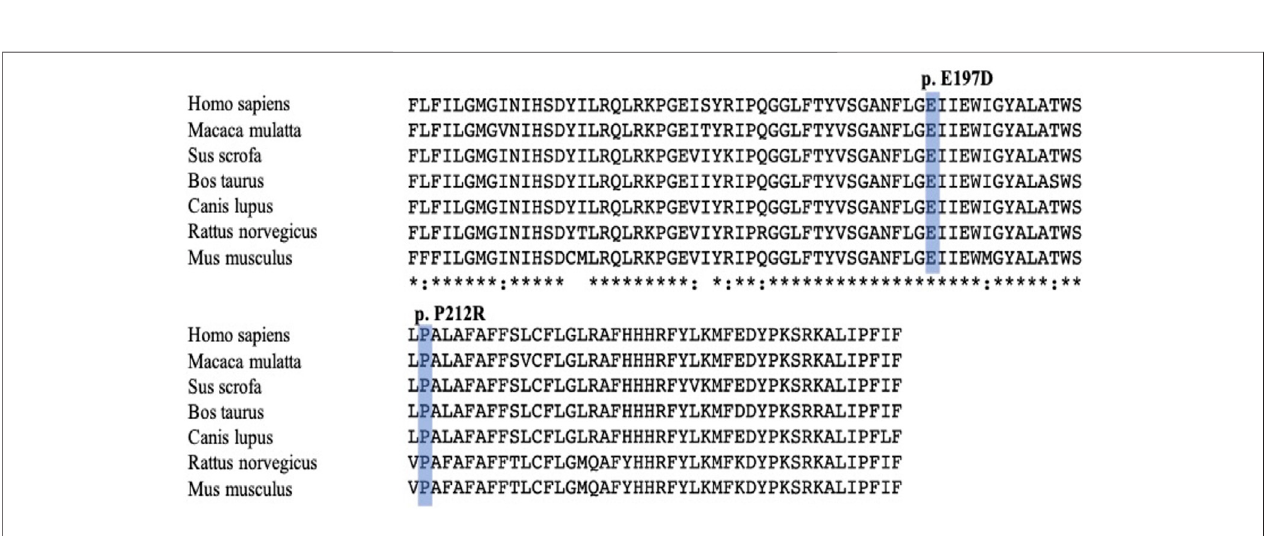
Frontiers in Genetics |